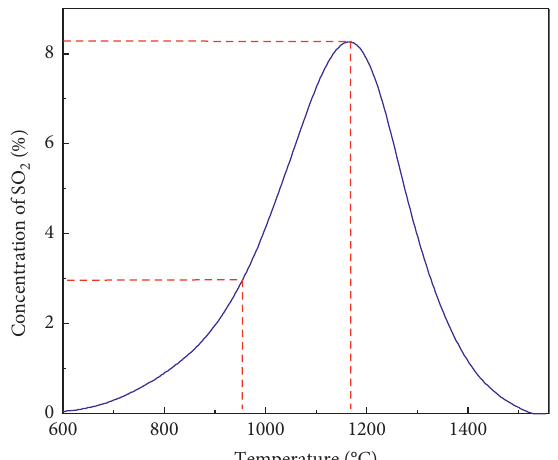
Figure 12: The release pattern of SO